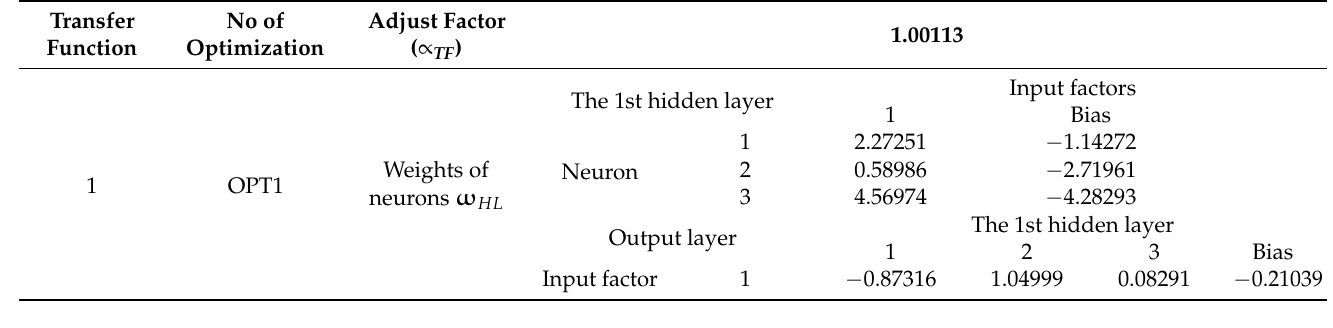
Table 5. Summary for the appropriate calibrated parameters of the ANN_GA-SA_MTF model at the 500th VIOT grid.